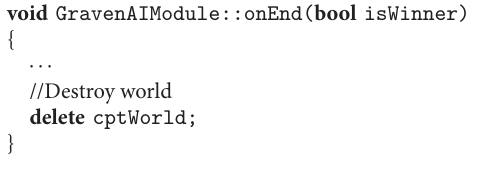
Algorithm 18: Conceptual view code in the onEnd callback func- tion. The conceptual world destructor also destroys associated objects.